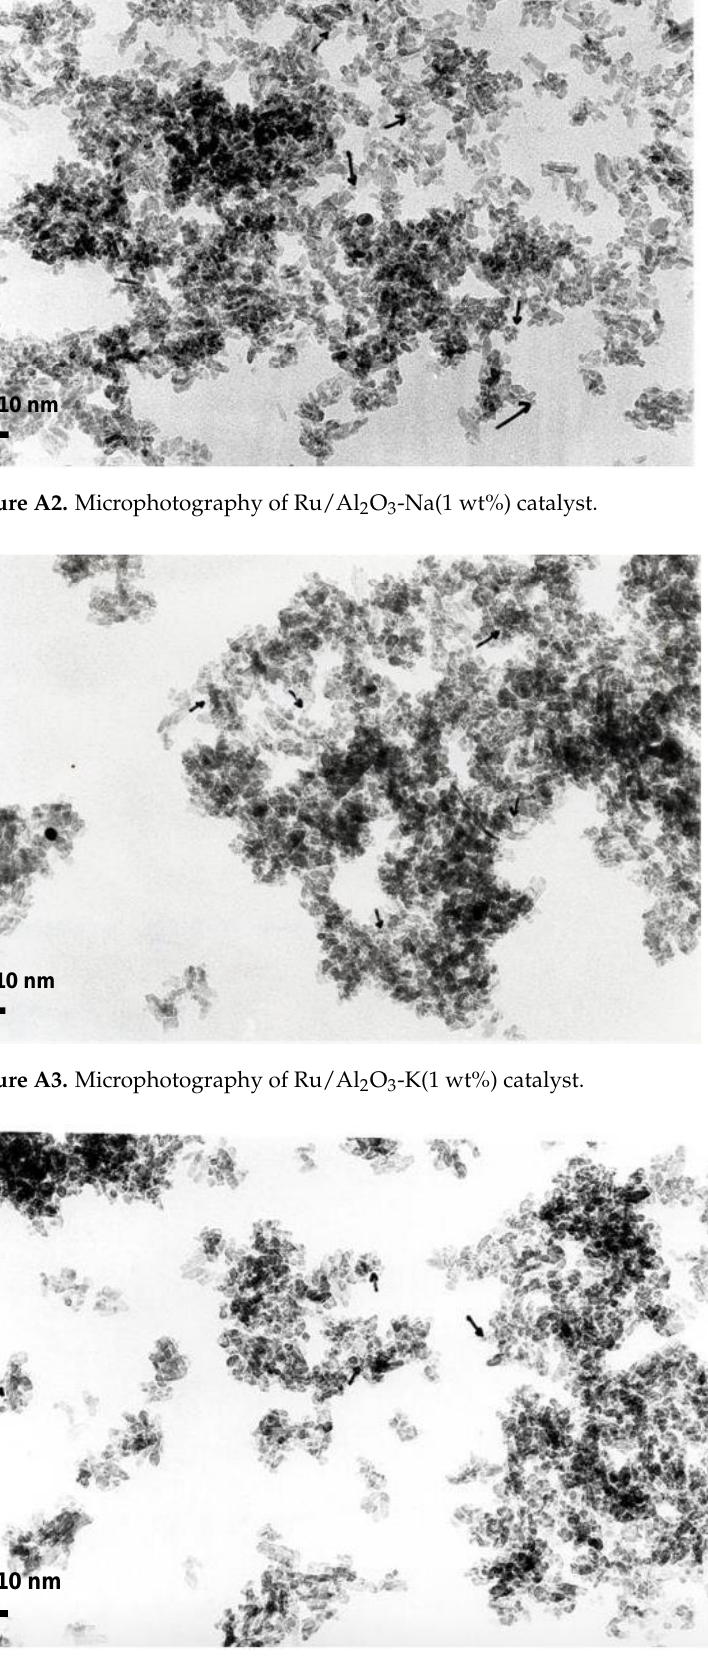
Figure A4. Microphotography of Ru/Al 2 O 3 -Mg(1 wt%) catalyst.